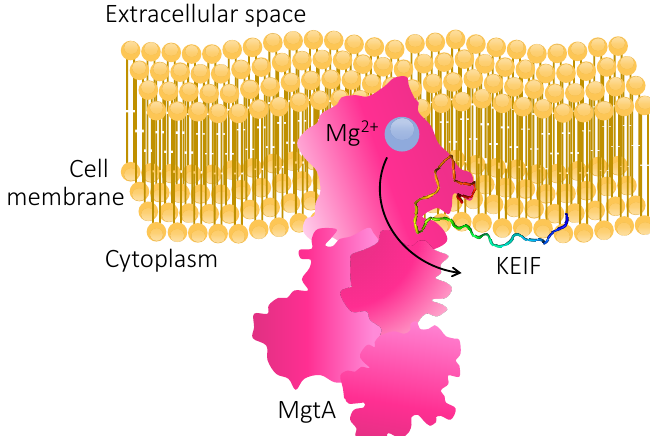
Figure 11. Schematic cross-section of an MgtA-carrying cell membrane. It is possible that KEIF plays the role of an anchor, helping to stabilise the large protein complex in the membrane by locking it in place via electrostatic interactions with anionic lipid head groups.